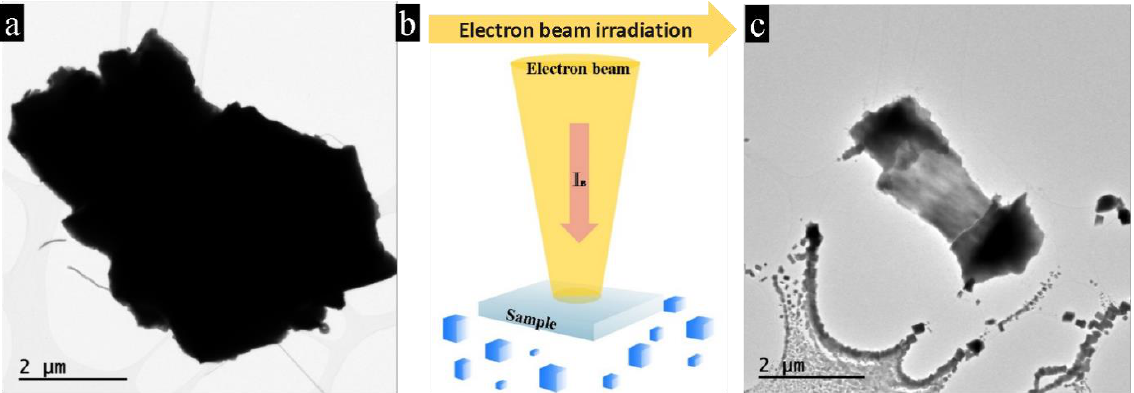
Figure 1. Formation of PbTe nano-bars during the electron-beam treatment. ( a ) Initial PbTe particle from an as-prepared single crystal before heavy irradiation. ( b ) Scheme of the formation of PbTe nano-bars. ( c ) The same PbTe particle after beam irradiation is remarkably decreased in size and is surrounded by nanoparticles of different sizes produced by the electron beam at bottom of the micrograph.